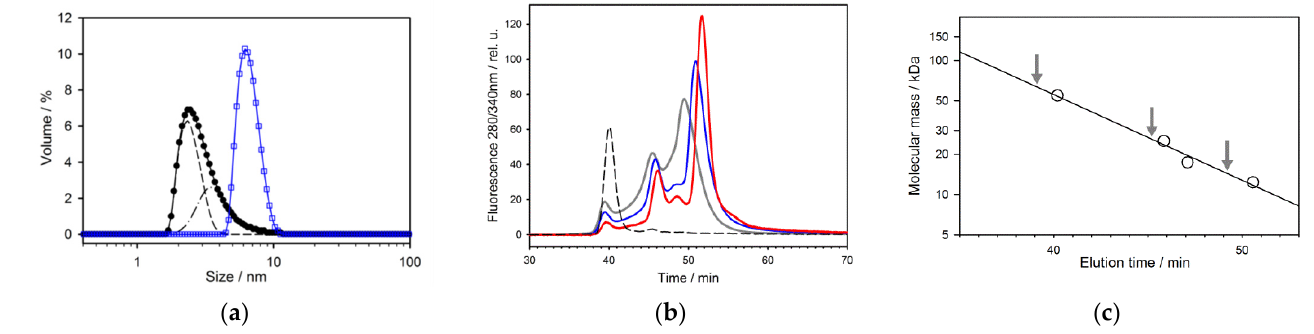
Figure 8. The hydrodynamic properties of pH-induced intermediates of Hfq Y55W. ( a ) Size distribution of Hfq Y55W at pH 7.6 or WT Hfq at pH 1.4 (blue squares) and that of Hfq Y55W at pH 1.4 (black circles) revealed by dynamic light scattering at a protein (monomer) concentration of 100 µ M. The deconvolution of the mutant peak at pH 1.4 into peaks corresponding to 35 Å (dashed-dot line) and 23 Å (dashed line); ( b ) The size-exclusion chromatography of Hfq Y55W on Superdex 200 10/300 GL at pH 1.4 and various applied protein concentrations: the grey line stands for 3.0 mg/mL (300 µ M monomer); the blue line for 0.6 mg/mL (60 µ M monomer); the red line for 0.12 mg/mL (12 µ M monomer). The dashed line shows the hexameric WT Hfq elution profile at pH 1.4; ( c ) The chromato- graphic column calibration. Proteins used for calibration are WT Hfq (54.6 kDa), chymotrypsinogen (25 kDa), myoglobin (17.3 kDa), cytochrome c (12.3 kDa). The arrows indicate the elution times of the peaks at 300 µ M protein concentration